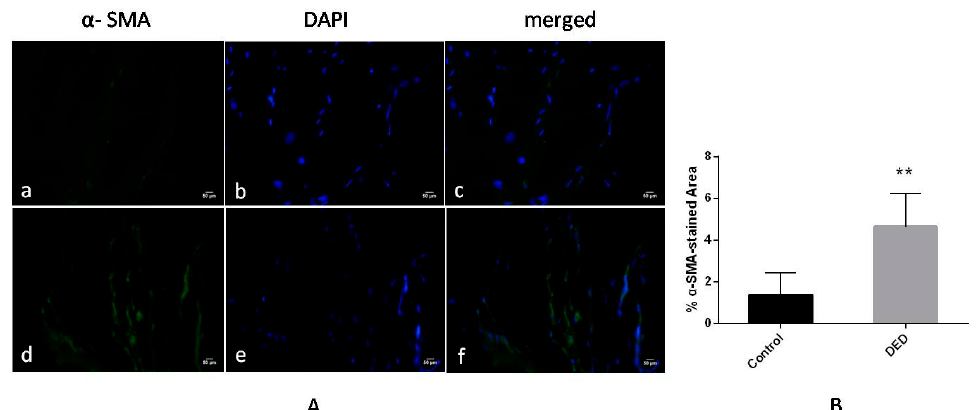
Figure 11. α -smooth muscle actin ( α -SMA) expression in the filtration blebs on day 28 ( α -SMA staining: green; nuclear staining: blue). ( A ) The α -SMA-stained area was larger in the DED group ( d – f ) than in the control group ( a – c ) (400×); ( B ) the percentage of α -SMA-stained area was significantly different between the two groups. ** p < 0.01. Scale bar = 50 μ m.